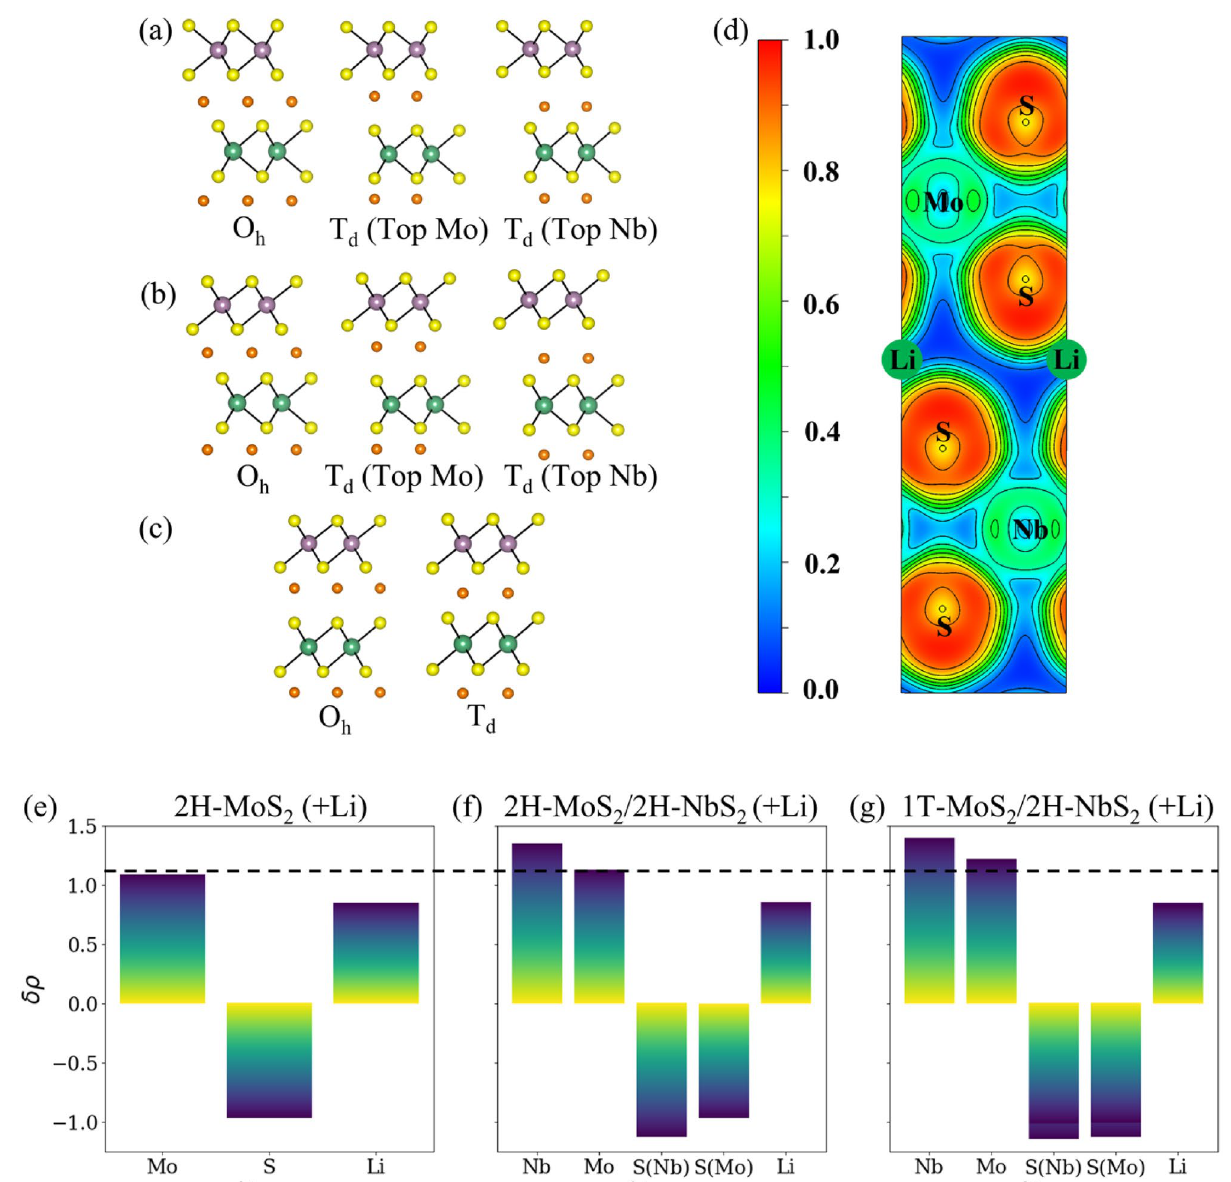
Figure 2. Different high symmetry binding sites considered for Li adsorption are shown in ( a ) 2H-MoS 2 /2H- NbS 2 , ( b ) 1T-MoS 2 /2H-NbS 2 , and ( c ) 1T-MoS 2 /1T-NbS 2 heterostructures. Purple, green, yellow, and orange spheres denote Mo, Nb, S and Li atoms respectively. ( d ) Electron localization function (ELF) projected on the [100] plane of lithiated 2H-MoS 2 /2H-NbS 2 . A positive value implies that the atom lost electrons, while a negative value indicates that the atom has gained electrons. The dotted line, corresponding to the charge on Mo-atom in lithiated 2H-MoS 2 /2H-NbS 2 , is added to compare the electronic charge on